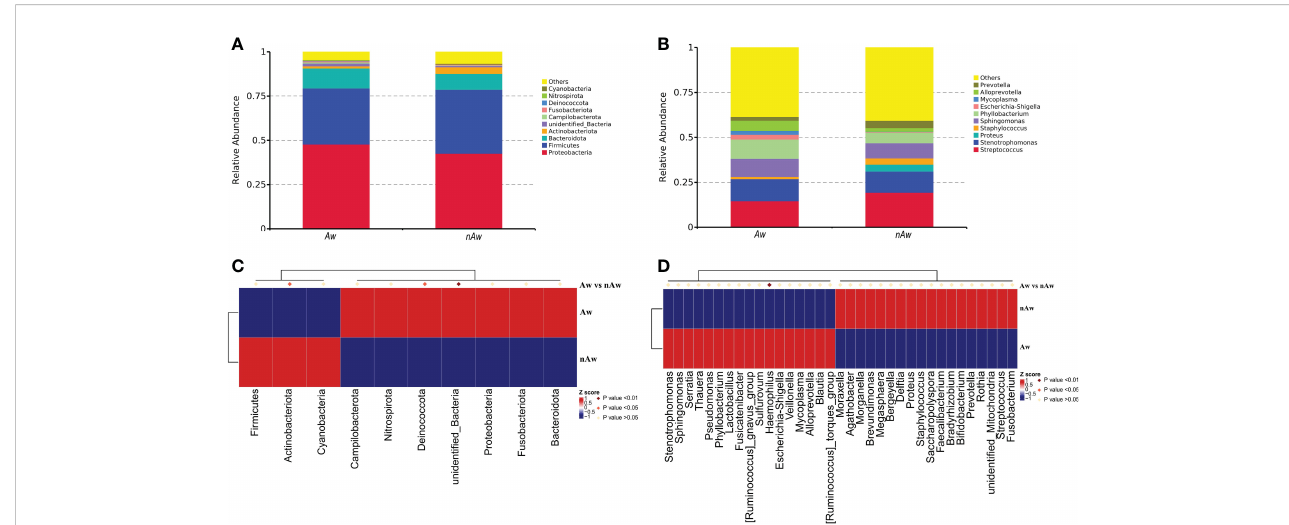
FIGURE 5 The distribution of taxa in phylum and genus levels of Aw and nAw. (A) composition of microbiome at the phylum level. (B) composition of microbiome at the genus level. (C) the statistical results of top 10 phylum. (D) the statistical results of top 35 genus. Aw, atopic wheezing group; nAw, non-atopic wheezing group.